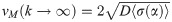
The asymptotic mean velocity increases with k in temporally varying environments.(A) Velocities obtained by numerical integration of Eq 5 for sa = 0.75, ss = 1, sb = 3 (yellow dot of Fig 2) for different switching rates k shown in the figure legend. (B) The same for sa = 0.25, ss = 1, sb = 2 (blue dot of Fig 2). In (A), the optimal strategy is α = 1 for all k values. In (B), bet-hedging optimal strategies appear depending on the value of k. The continuous red and yellow lines (both in A and B) illustrate analytical predictions under the two limits vM(k → 0) = (va(α) + vb(α))/2 and vM(k→∞)=2D〈σ(α)〉, respectively.